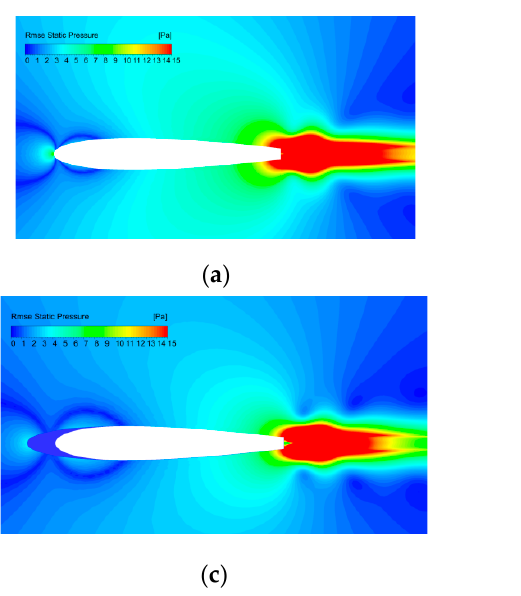
Figure 11. Distribution of the pressure fluctuations on the airfoil’s surface: ( a ) baseline; ( b ) A10W10.